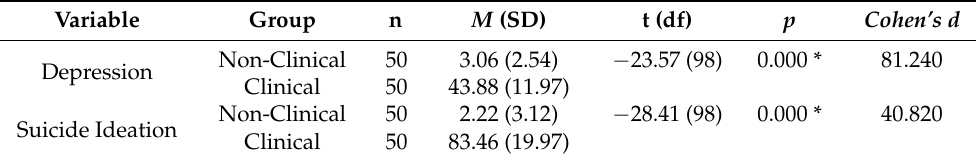
Table 4. Depression and suicide ideation scores by non-clinical and clinical groups.